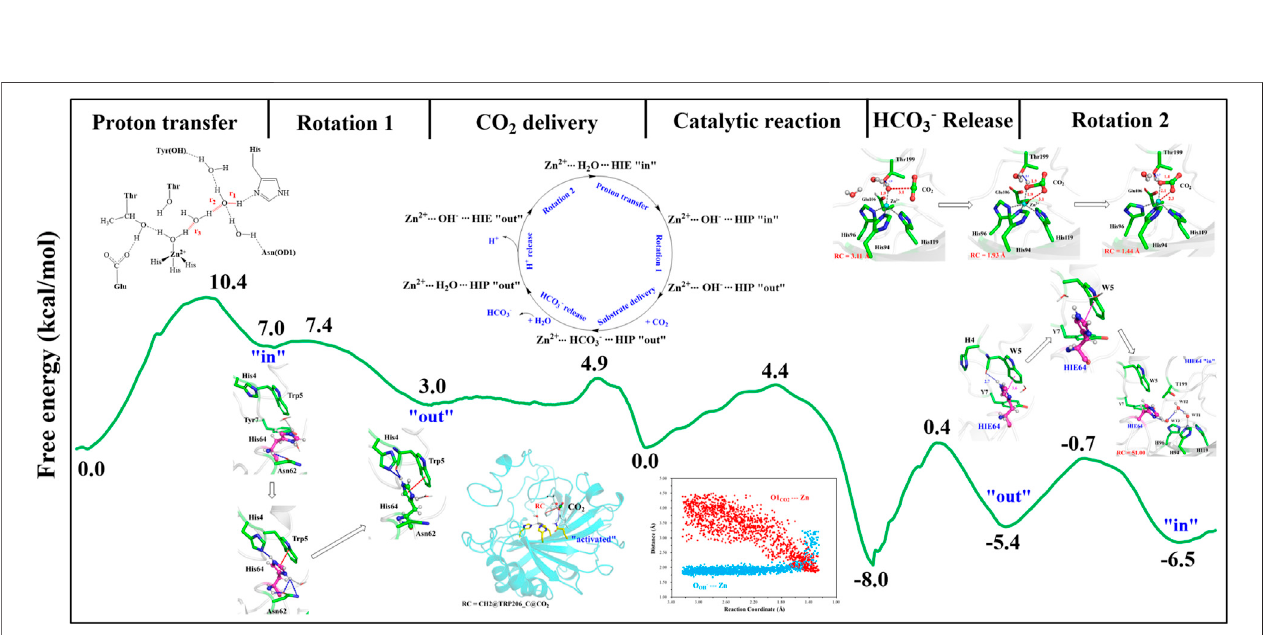
FIGURE 14 | Free energy profiles for the entire enzymatic catalytic